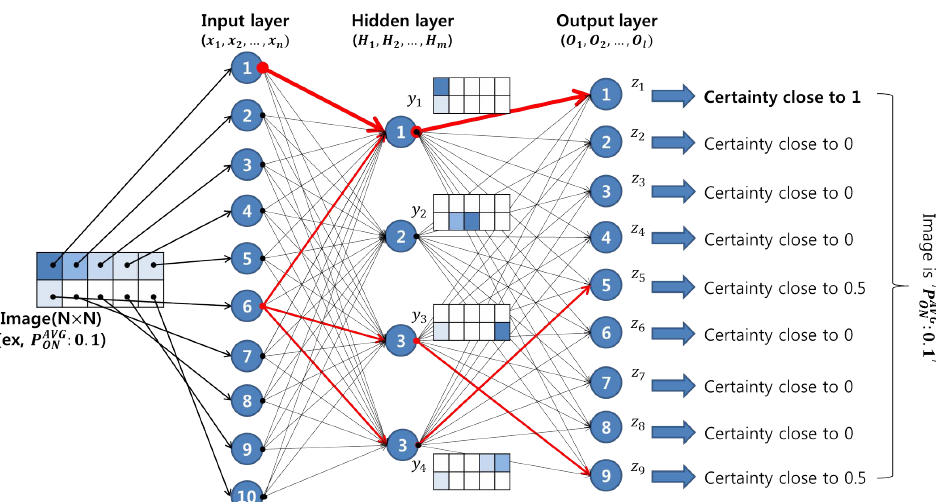
Figure 4. Artificial neural network